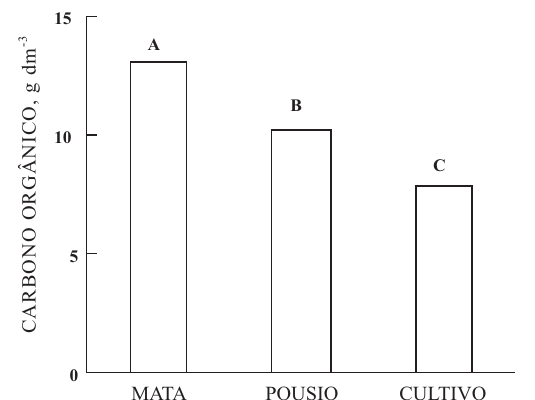
Figura 2. Teores médios de carbono orgânico do solo para os tratamentos mata, pousio e cultivo.